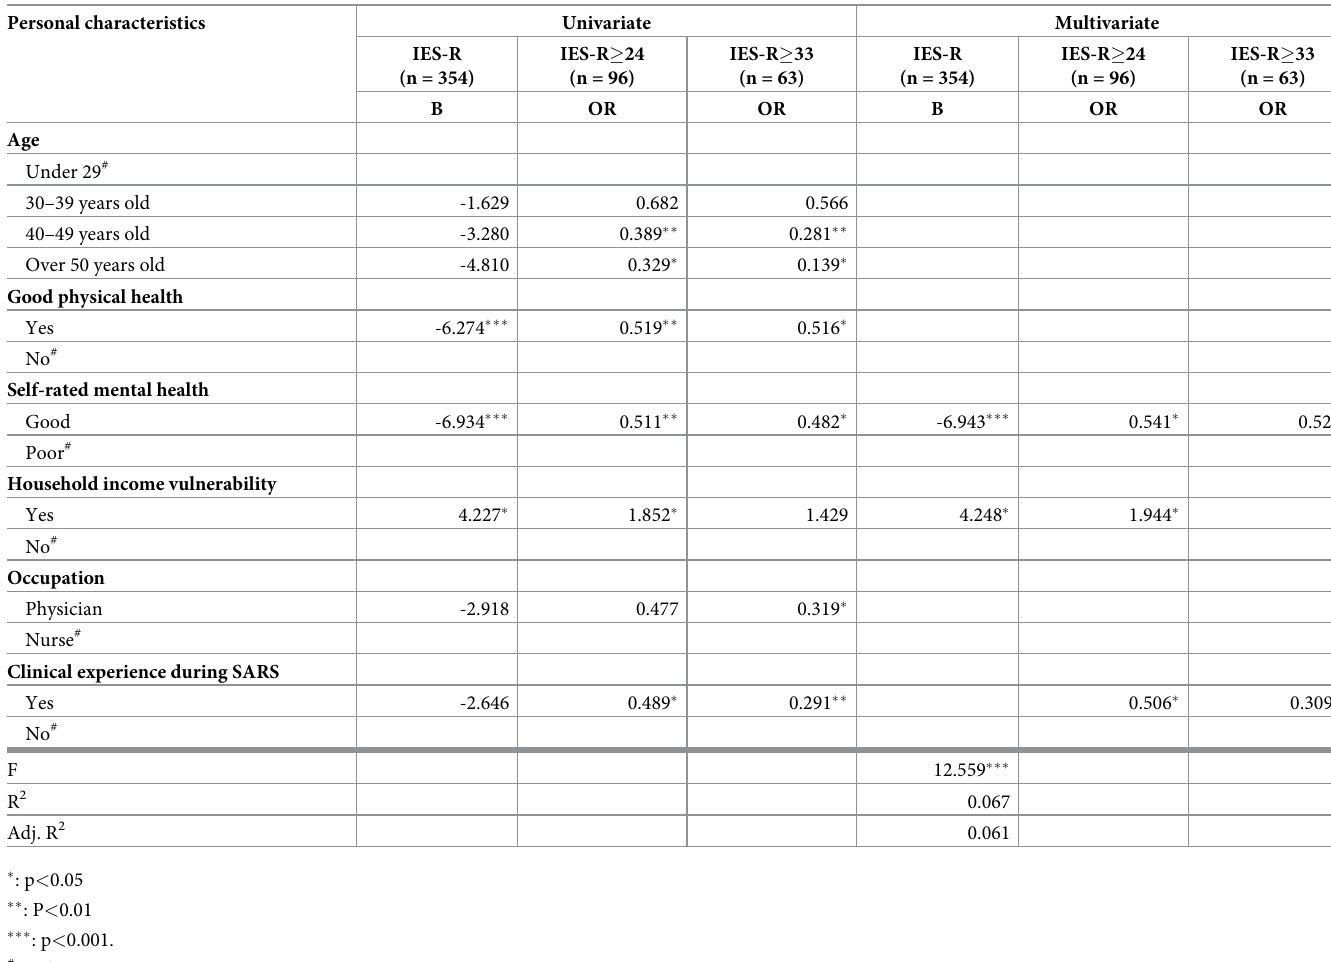
Table 5. Univariate and multivariate stepwise regression and logistic regression analysis of IES-R related factors. Personal